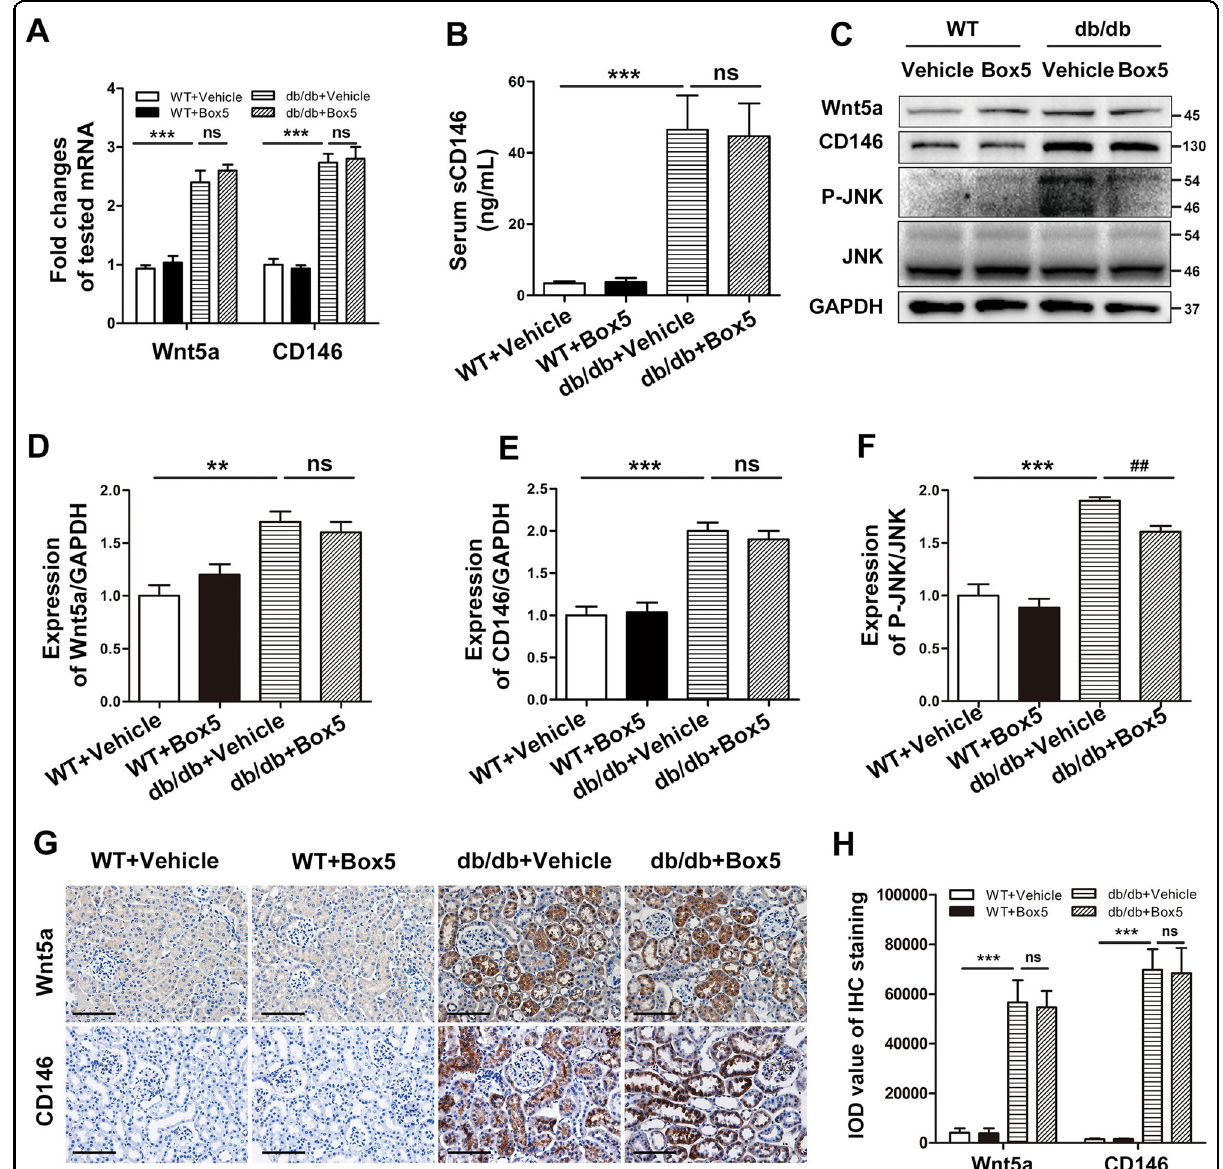
Fig. 5 Box5 prevented in fl ammatory responses by blocking the activation of noncanonical Wnt5a signaling. A The mRNA levels of Wnt5a and CD146 were determined by real-time PCR in all groups. *** P < 0.001, versus WT + Vehicle mice, ns, no signi fi cance. B The concentration of sCD146 in the serum was determined by ELISA in all groups. *** P < 0.001, versus WT + Vehicle mice, ns, no signi fi cance. C – F Western blot analysis and densitometric quanti fi cation of Wnt5a, CD146, the phosphorylated JNK and total JNK in all groups of mice. *** P < 0.001, ** P < 0.01 versus WT + Vehicle mice, ## P < 0.01, versus db/db + Vehicle mice, ns, no signi fi cance. G Immunohistochemical staining of Wnt5a and CD146 in kidney tissue of all groups. Original magni fi cation, ×400; scale bar, 50 μ m. H Quantitative analysis of the expression of Wnt5a and CD146 staining on kidney sections of each group according to the average IOD. *** P < 0.001, versus WT + Vehicle mice, ns, no signi fi cance. PCR experiments were performed in triplicate. Western blotting and immunostaining were performed in duplicate. Representative pictures of eight mice were shown. All values were presented as the mean ± SD. Two-sided unpaired t -tests and one-way ANOVA followed by Bonferroni multiple comparison test were